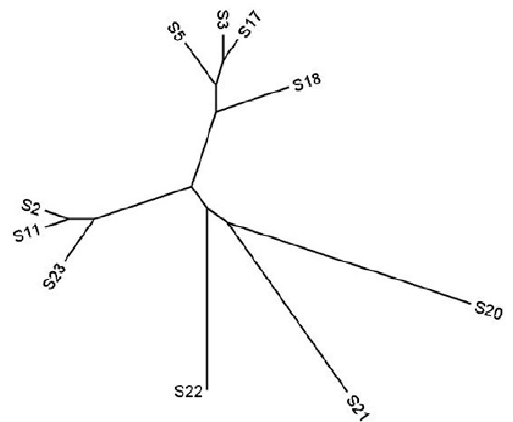
Figure 4. UPGMA dendrogram of the Nei’s genetic distance among 10 clones obtained with dominant and co-dominant molecular markers.